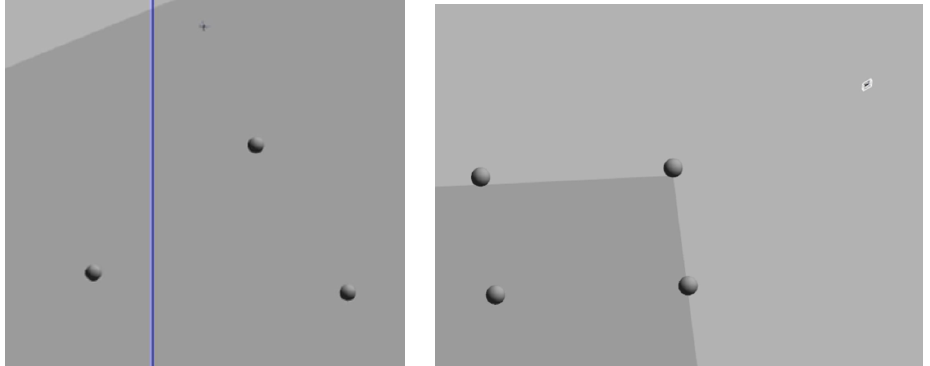
Figure 9. The cruising simulation of the flying robot. The figure on the left shows the drone cruising around the 3-object group, and the figure on the right is drone cruising around 4-object group.